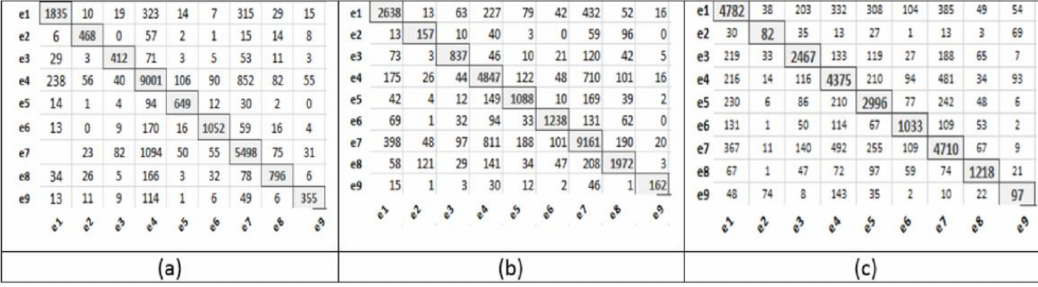
Figure 8. Best-case confusion matrices obtained for inferring emotion tags based on bottom-level object categories using K-NN classifier with ( a ) male responses, ( b ) female responses, ( c ) combined responses. The columns represent the predicted values, while the rows represent the ground truths. Here, e1, e2, e3, ... , e9 represent Amusement, Anger, Awe, Boredom, Contentment, Disgust, Excitement, Fear, and Sad emotion,